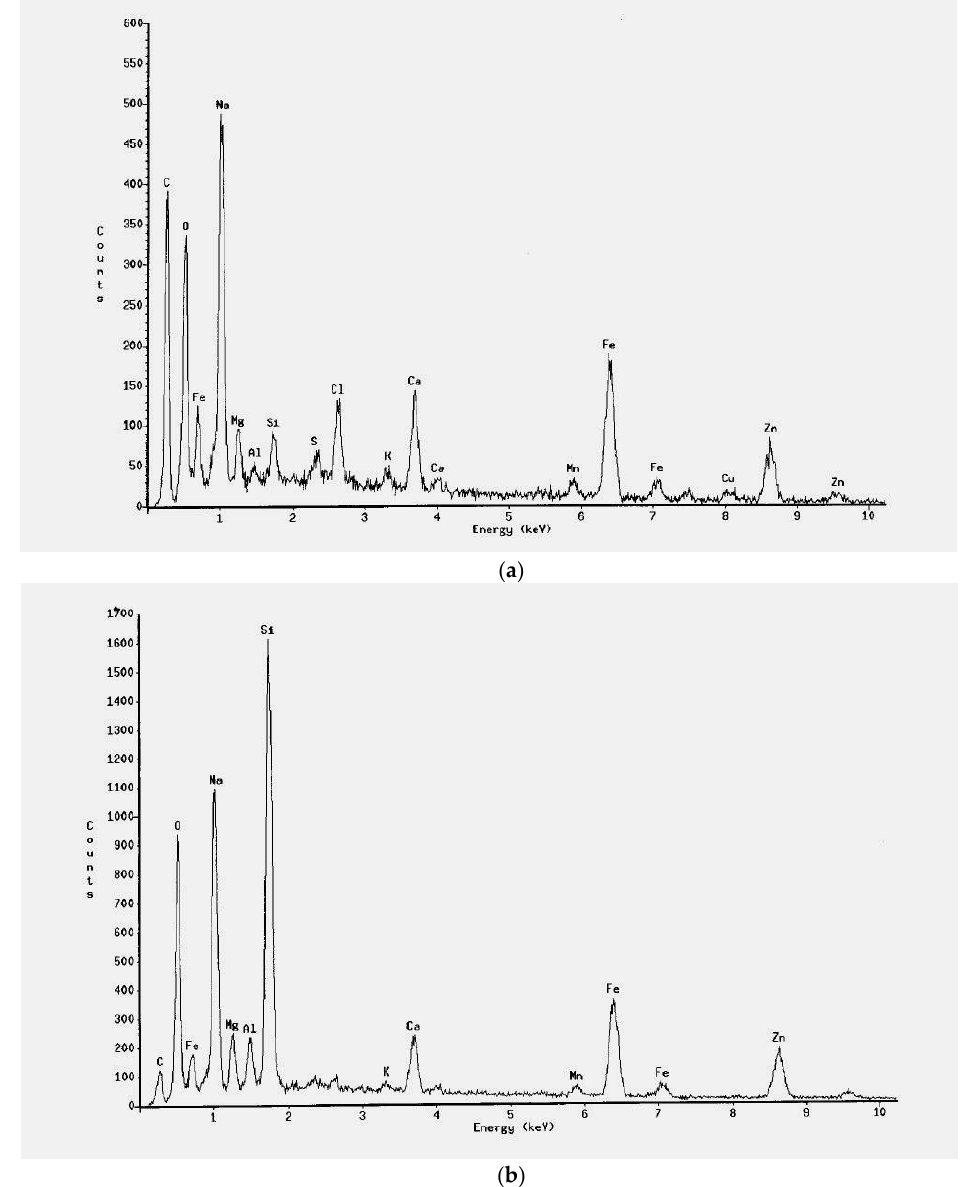
Figure 3. Results of EDS analysis of the dust before ( a ) and after ( b ) ISV treatment